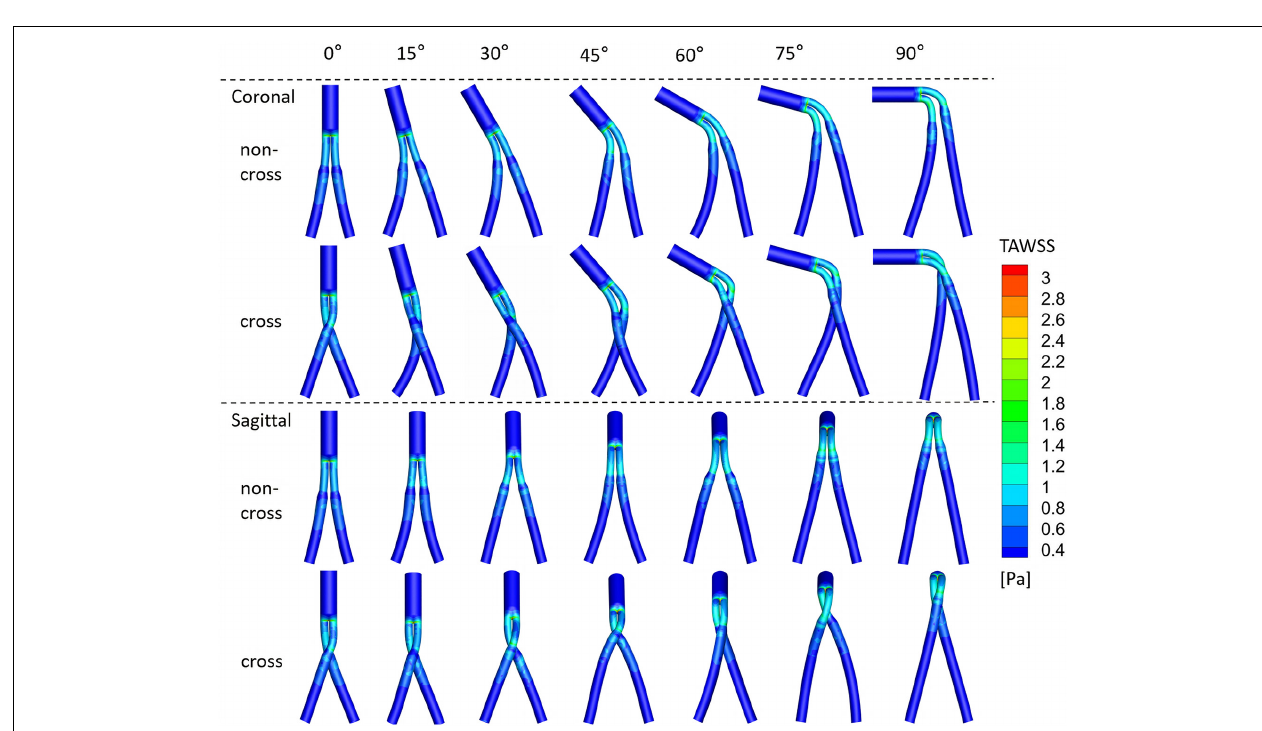
FIGURE 6 | Contours of TAWSS, with different colors to represent the magnitude of